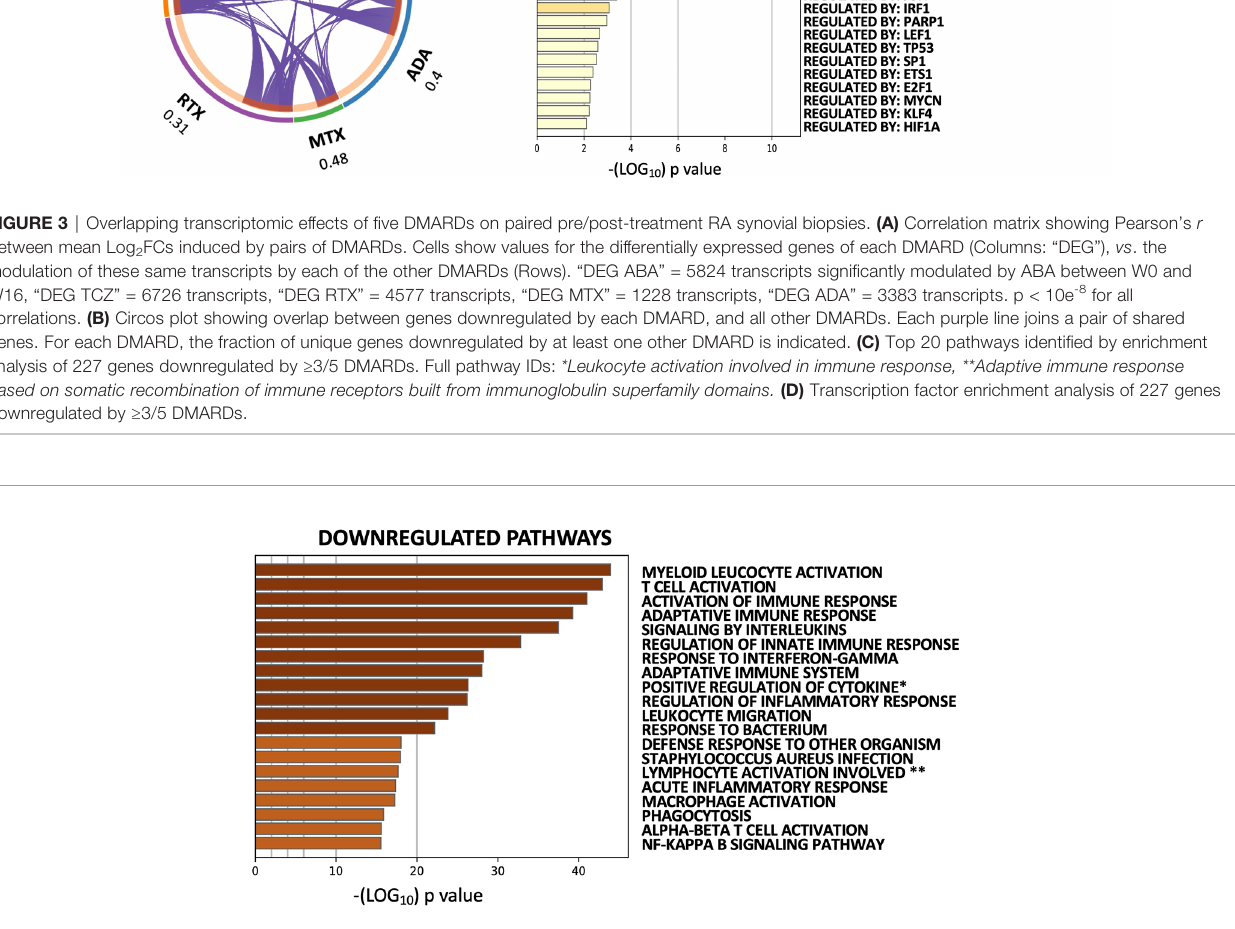
FIGURE 4 | Common transcriptomic effects of fi ve DMARDS identi fi ed by pooled analysis of 50 paired pre-/post-treatment RA synovial biopsies. Top 20 pathways identi fi ed by enrichment analysis of 573 genes downregulated by DMARDs (paired Mann-Whitney with Benjamini-Hochberg corrected p-value <0.05). Full pathway IDs: *Positive regulation of cytokine production. ** Lymphocyte activation involved in immune response.